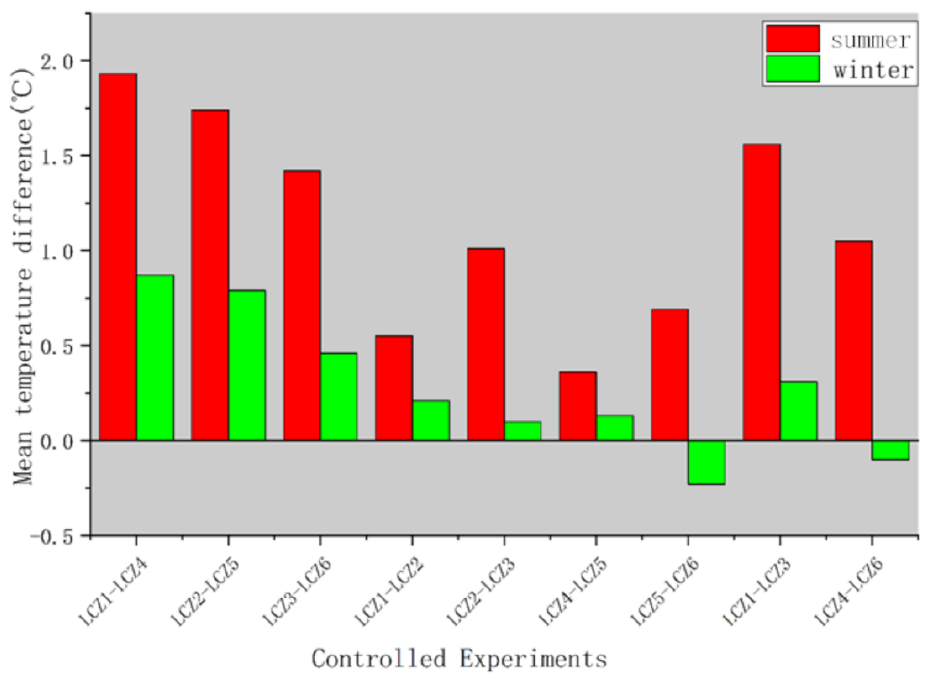
Figure 7. Mean LST differences of built-up LCZ categories in Wuhan. Table 5. q value calculation results for potential driving factors of LST in Wuhan’s major city core in summer and